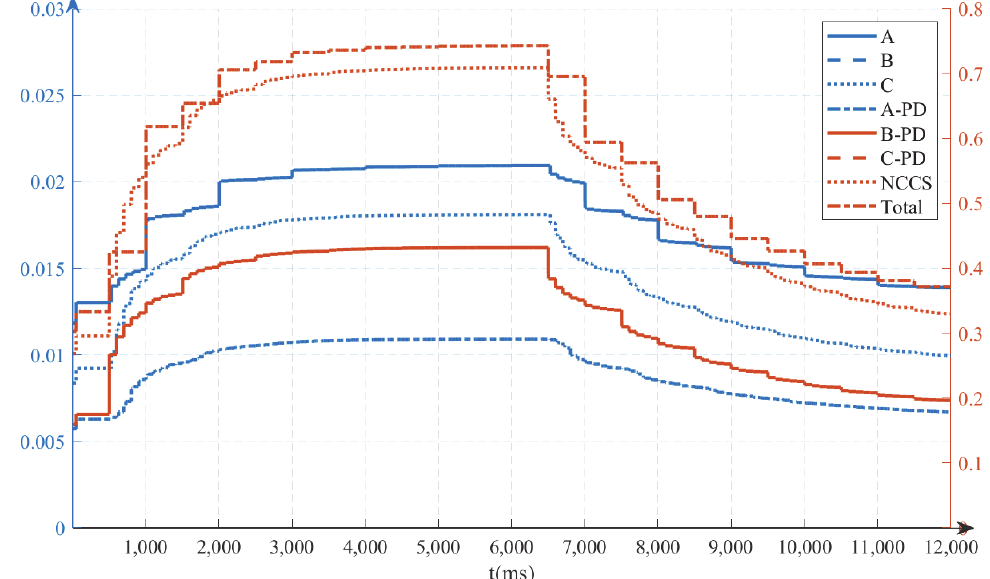
Figure 8. Dynamic change of failure probability after the attack.